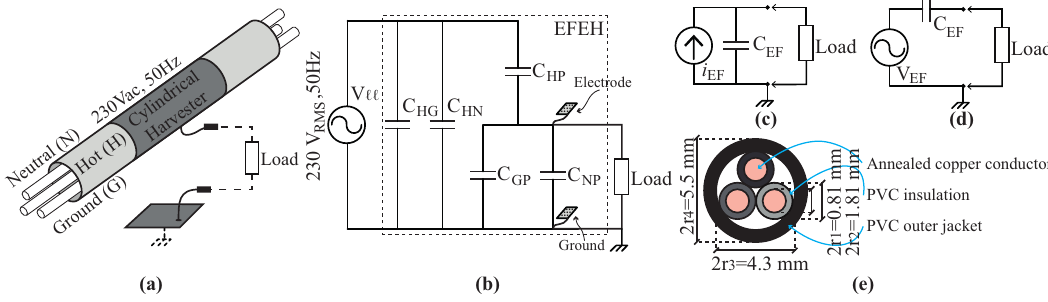
Figure 2. Schematic diagrams of electric field energy harvesting (EFEH) topology. ( a ) Single-electrode concept; ( b ) capacitive network, showing parasitic capacitors; ( c ) single-capacitor current model; ( d ) single-capacitor voltage model; ( e ) cross section of the electrical